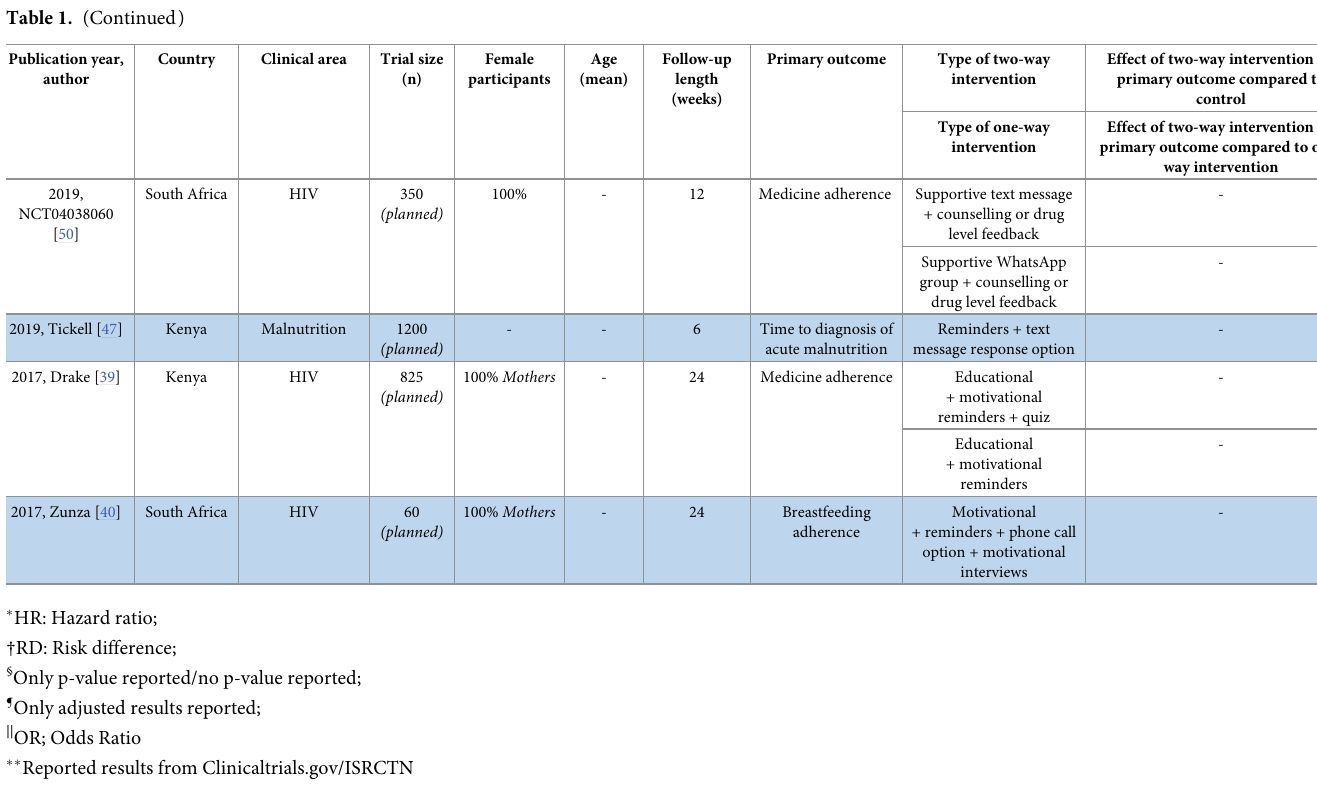
Therefore, these outcomes were only analyzed descriptively.